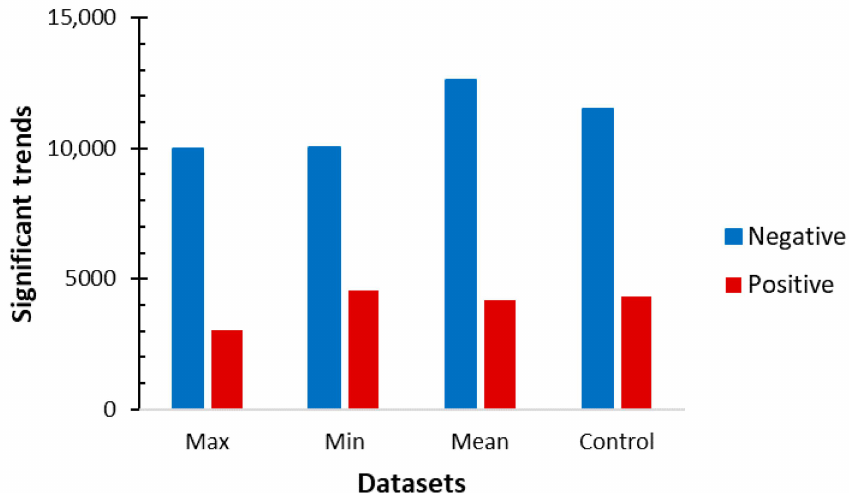
Figure 3. Comparison between the significant trends in the four datasets (confidence level of